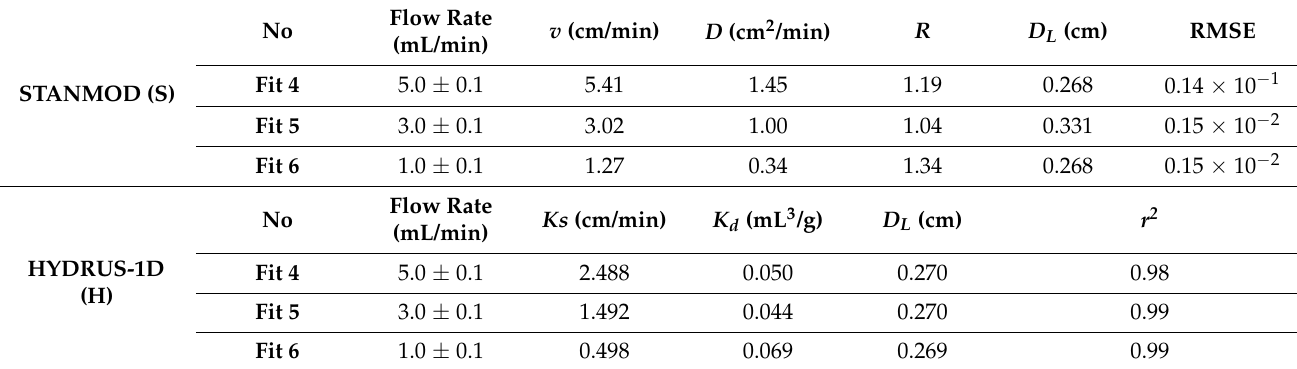
Table 4. The parameters for fitting IO 3 − BTCs.